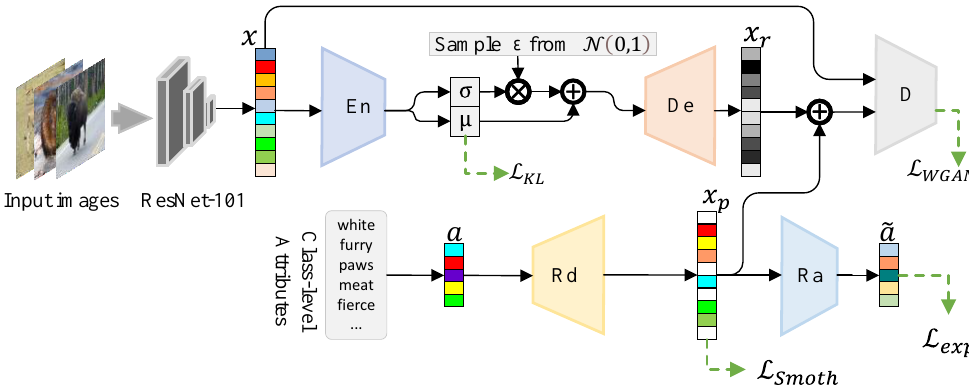
Figure 1. The overall framework of our proposed residual-prototype-generating network (RPGN). The backbone is ResNet-101 pre-trained on ImageNet to extract visual features of images, and its parameters are fixed and no longer fine-tuned in any of the